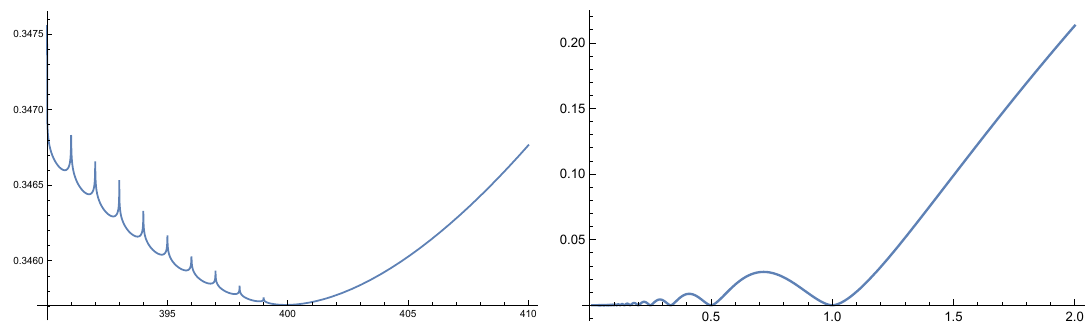
log Z Chern-Simons divided by N 2 with − [390 , 410] as real value. The function is diverging (cid:12) (cid:12) ∈ (cid:12) (cid:12)